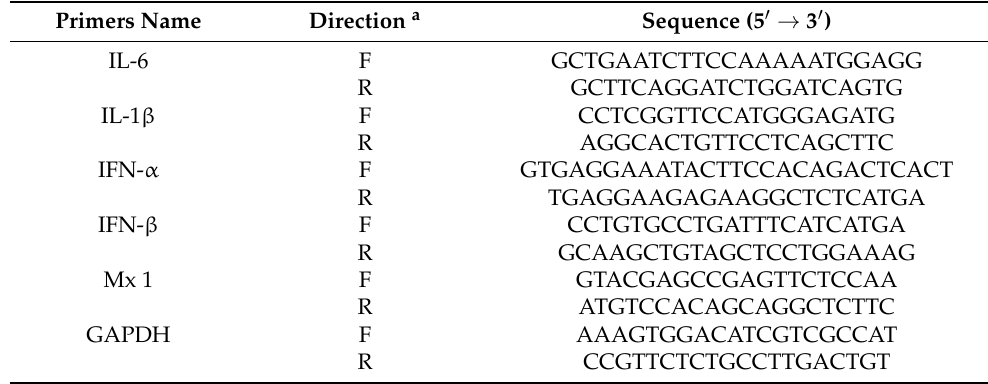
Table 1. Sequences of the primers used for RT-qPCR. a F = forward; R =